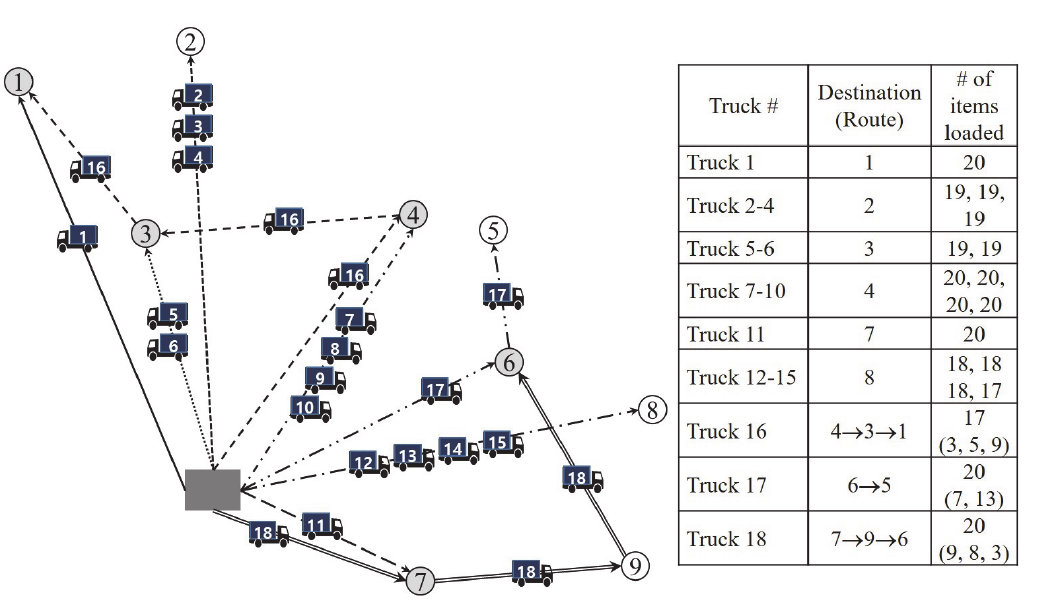
We can observe an important difference between the item quantities of TL-5 and TL-6 for destination 3 of the first truck-loading decision in Table 2 and those of the second decision in Table 3. In the first decision, the number of items loaded in each truck is determined as the value between the minimum requirement for TL freight charge and the maximum capacity of the truck, instead of making full truckloads, as in the second decision. We can also find the same difference for destination 8. The total costs for the first and second decisions are 1,880 ((100  15)+(120  1)+(130  2)) and 1,896